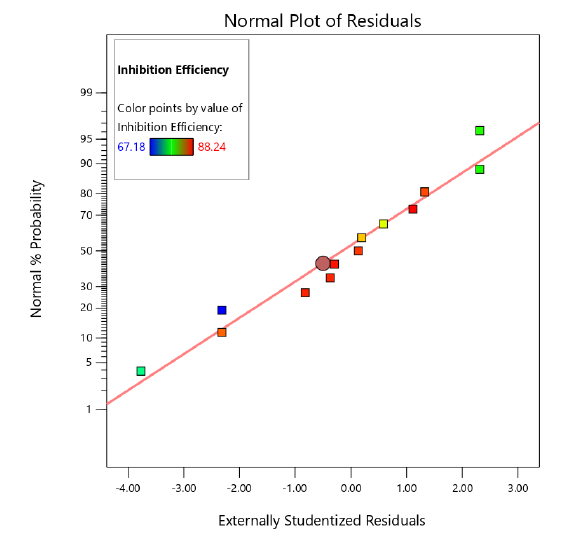
Fig. 4. Normal probability plot of residuals of CPP